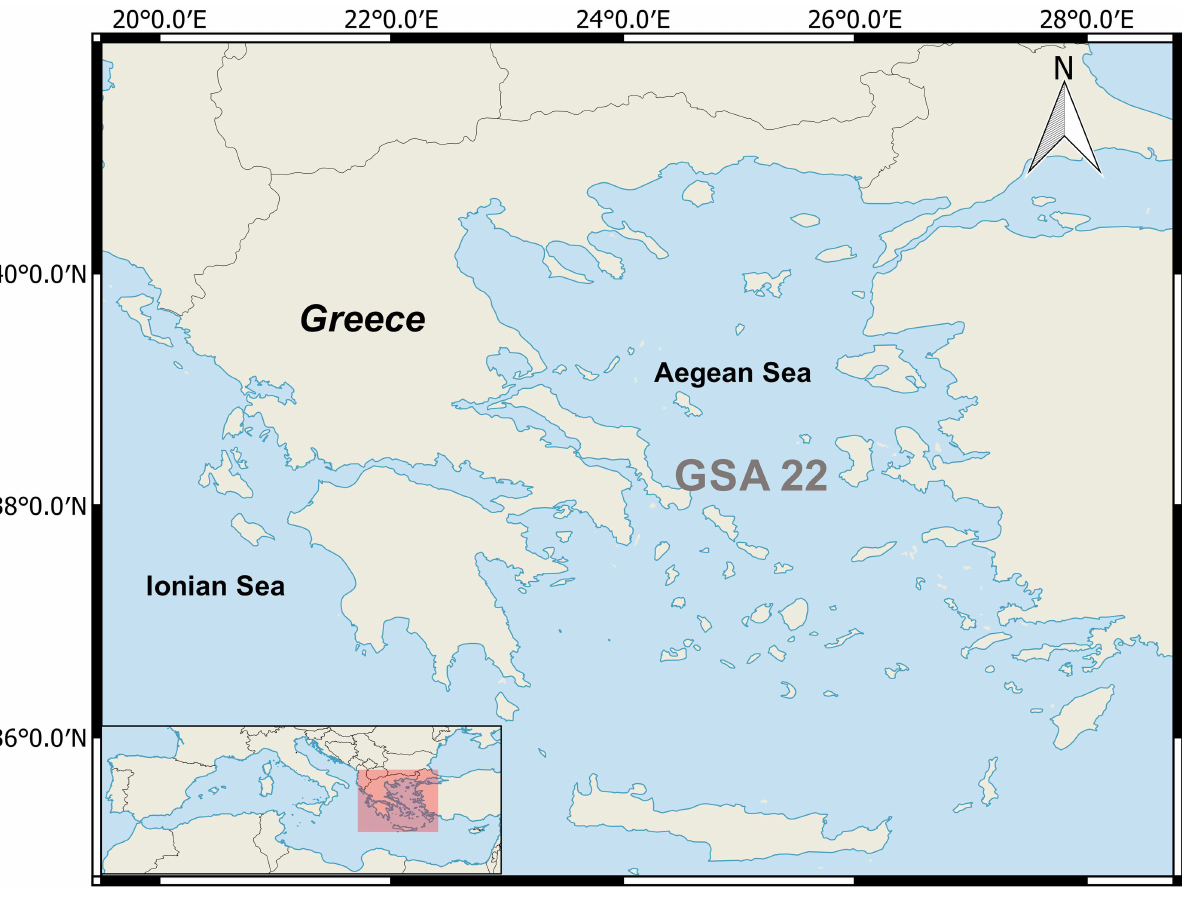
Fig 1. Map of the